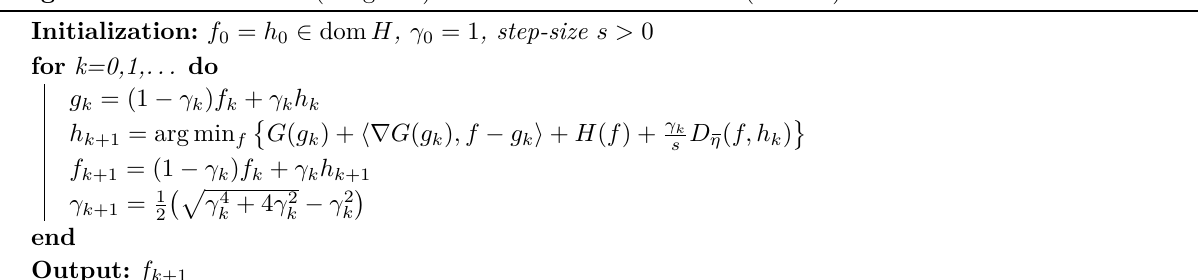
Algorithm 2: Accelerated (Bregman) Proximal Gradient Method